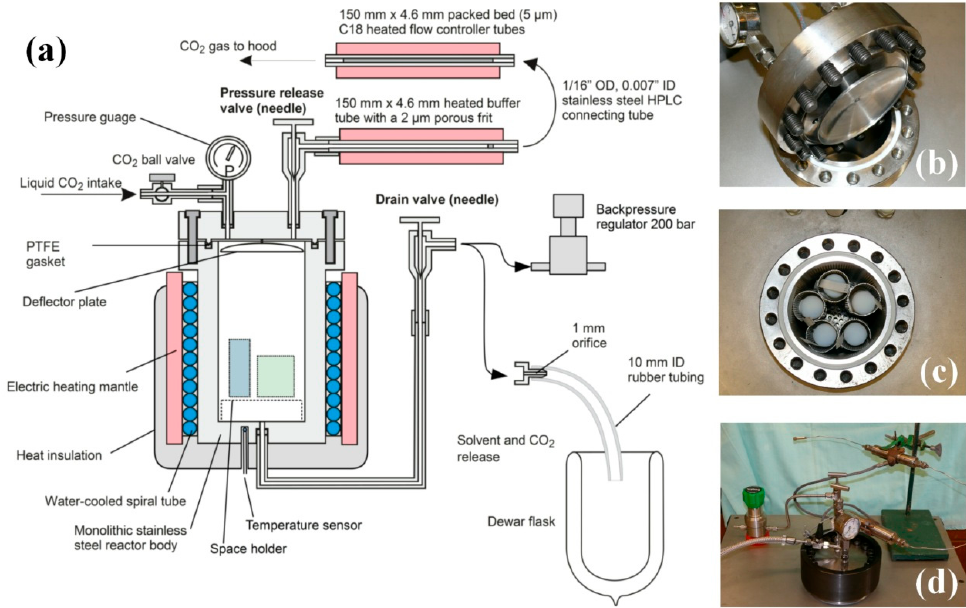
Figure 4. ( a ) Functional drawing of the supercritical dryer, and photographs of ( b ) unassembled reactor lid with deflector plate; ( c ) reactor body containing freshly dried cylindrical aerogel monoliths, and ( d ) assembled reactor with flow controller tubes and back pressure regulator unit.